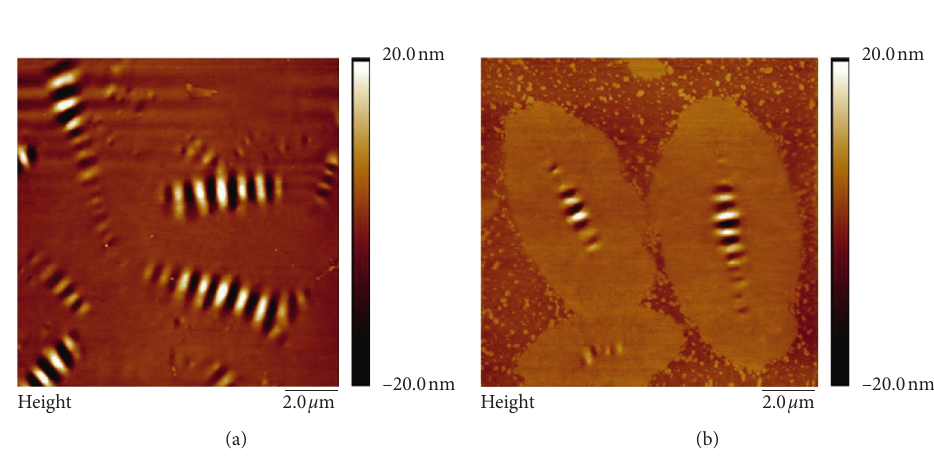
Figure 4: 2D AFM image of the (a) MRMA and (b)